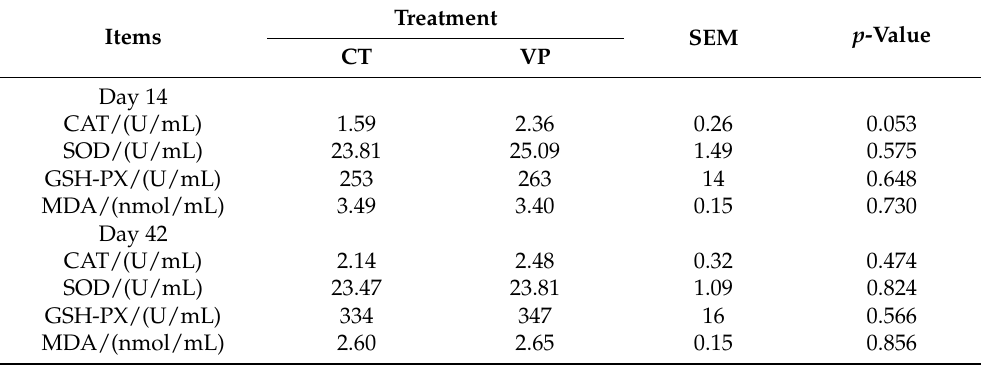
Table 3. Effect of dietary supplementation with stimbiotics on plasma antioxidant capacity of weaned piglets.